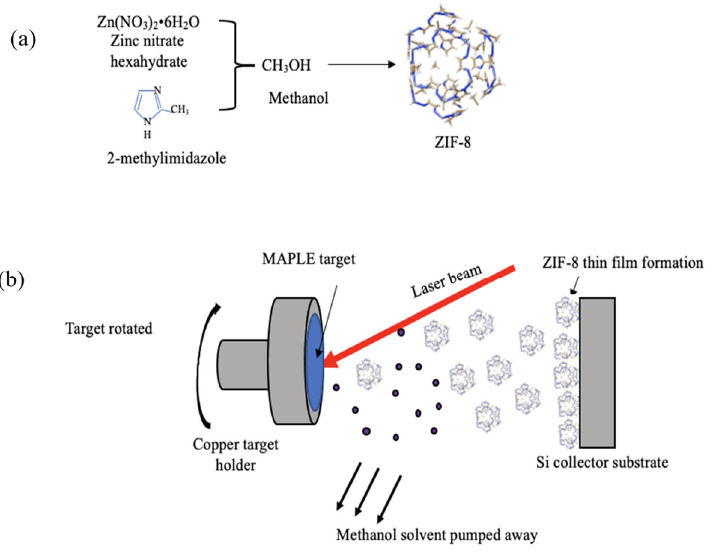
Figure 1. ( a ) Schematic representation of the synthesis process of ZIF-8 MOF particles when using methanol as a solvent. Grey atoms represent the zinc atoms, tan represents the carbon atoms, and white shows the hydrogen atoms. ( b ) Schematic of the controlled deposition of a thin film of ZIF-8 using the MAPLE technique.